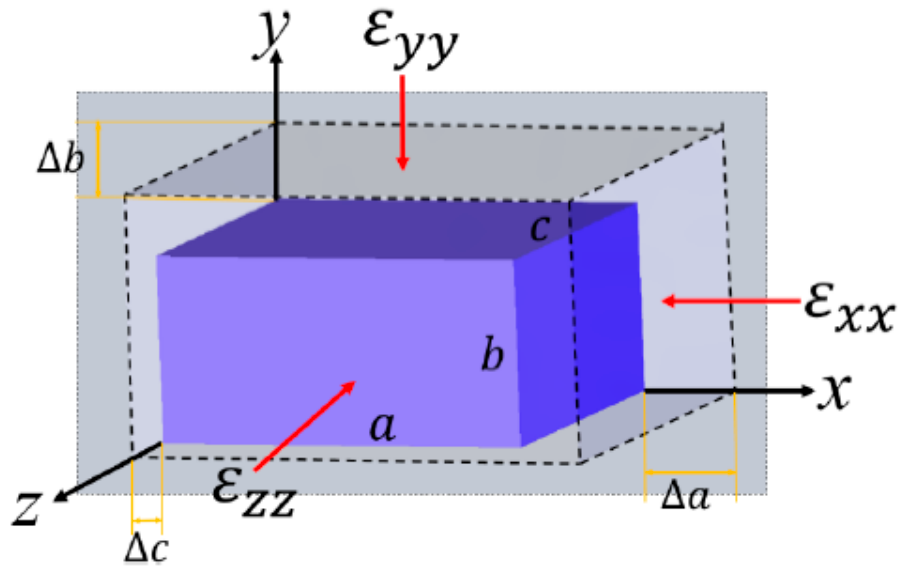
Figure 6. Thermal deformation schematic diagram.